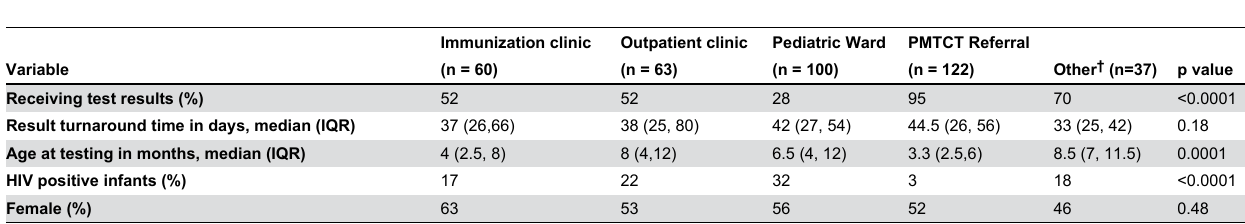
Table 2. Characteristics of the Study Sample from the Early Infant Diagnosis Program by Clinic Entry Point.